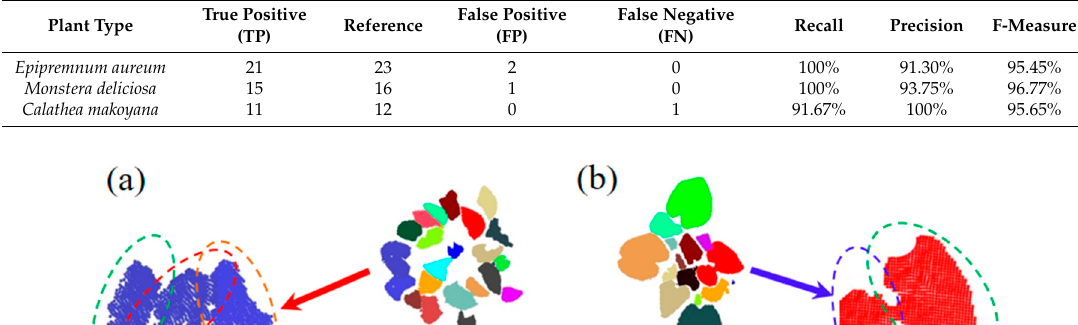
Table 2. Quantitative results of the proposed method.